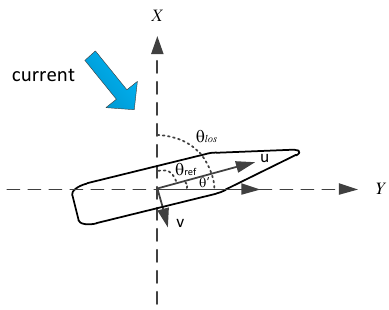
Figure 8. Schematic diagram of heading deviation and the